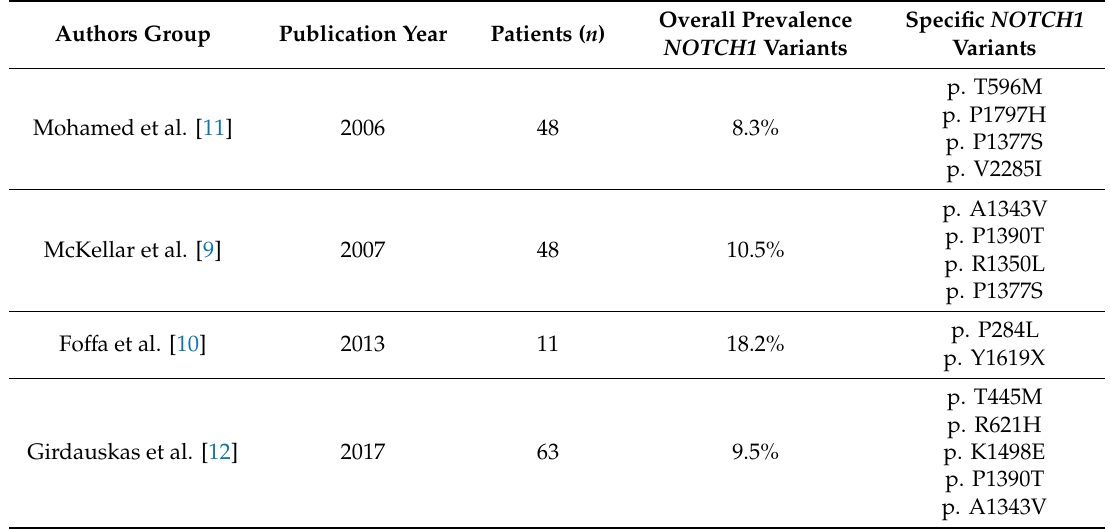
Table 1. NOTCH1 mutations published in association with bicuspid aortic valve (BAV) and